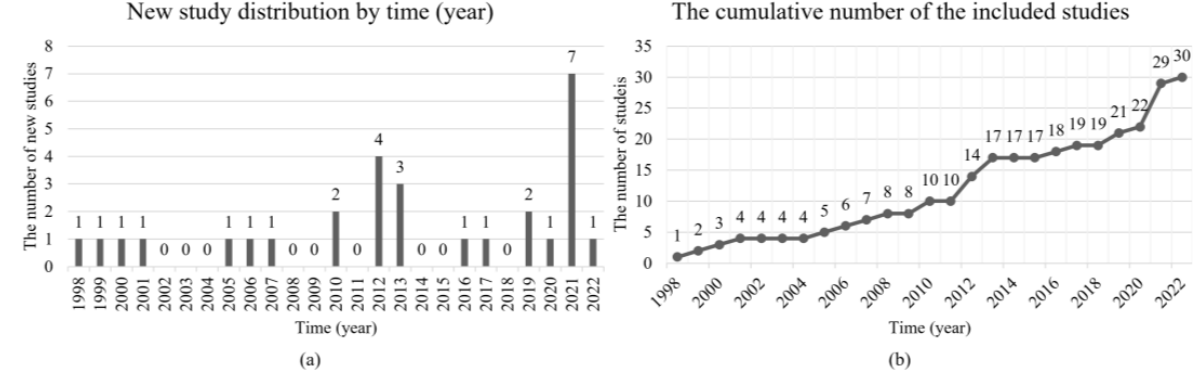
Figure 2. The statistics of the new studies in the Included Study . ( a , b ) Refer to the increasing and cumulative number of the Included Study .